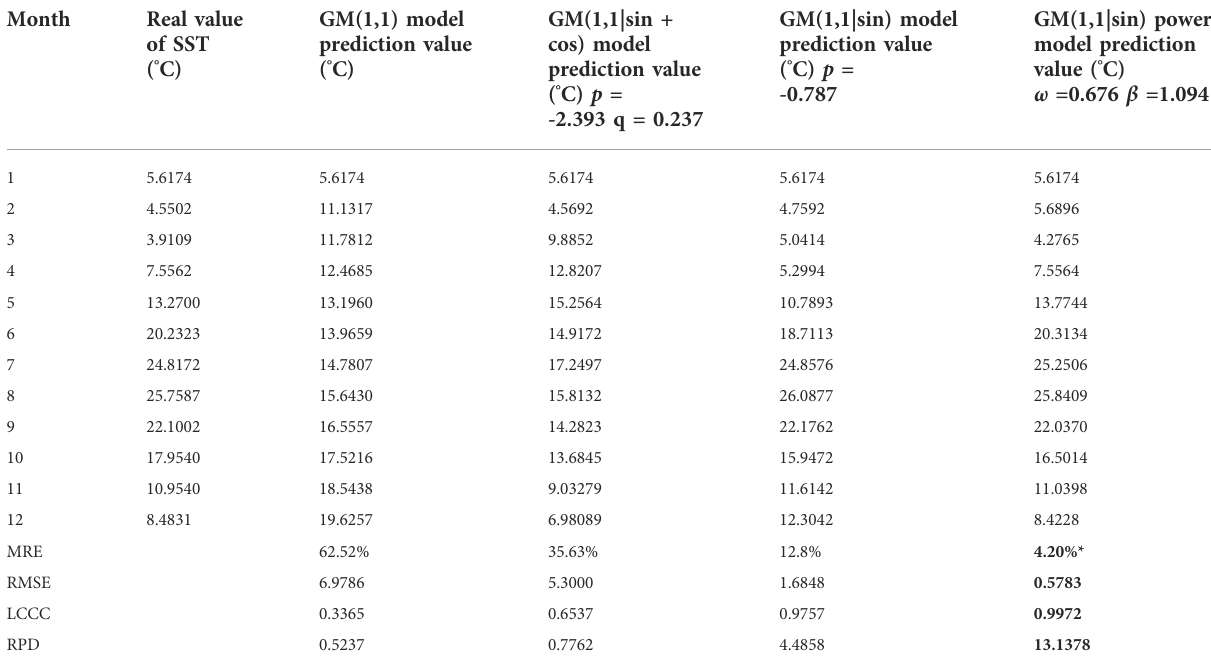
TABLE 9 Different models data of months average SST in 2020.